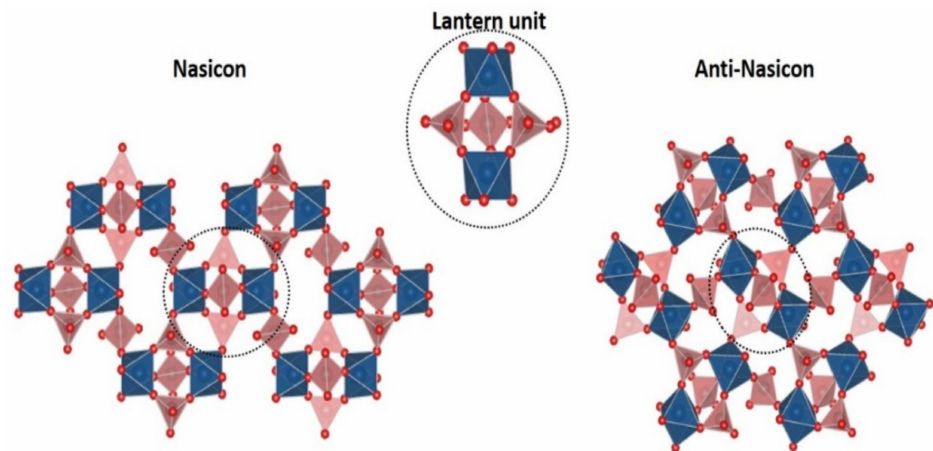
Figure 3. Structural relationship between Nasicon ( left ) and anti-Nasicon ( right ) structures adapted from ref. [18].